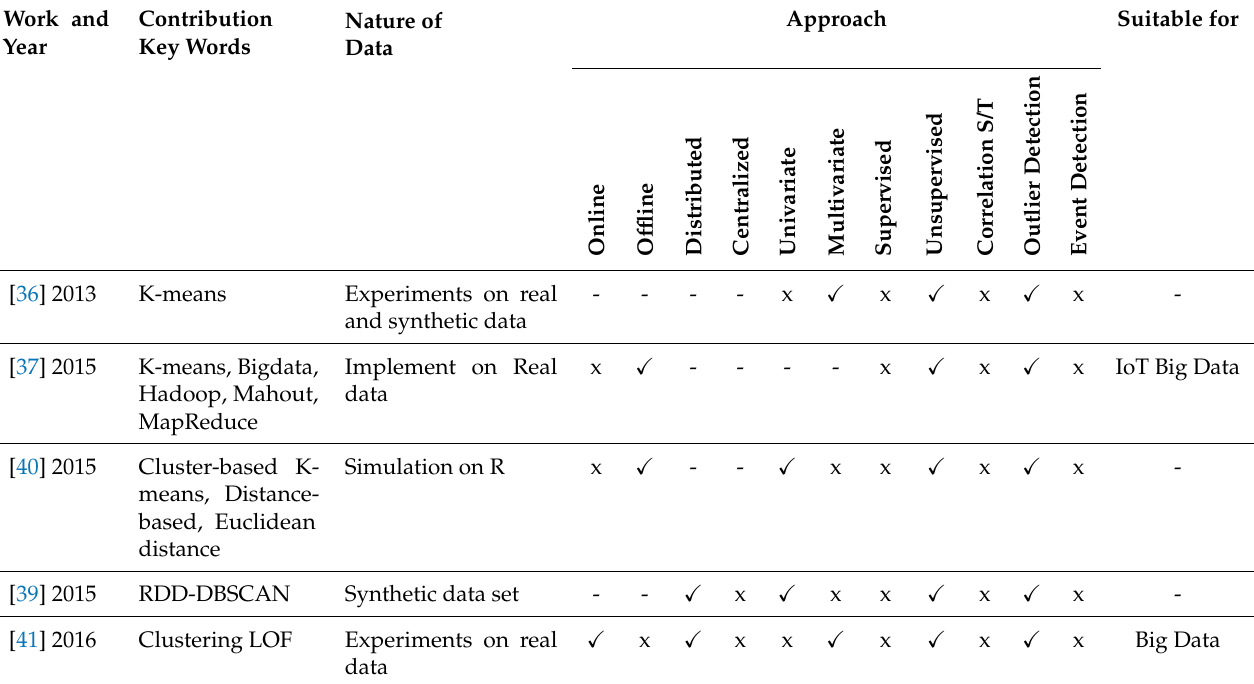
Table 3. Comparative Table of Clustering Based